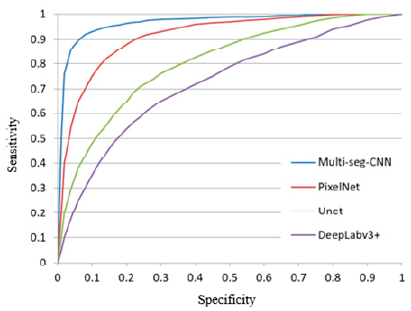
Figure 10. The ROC curve of di ff erent frameworks.